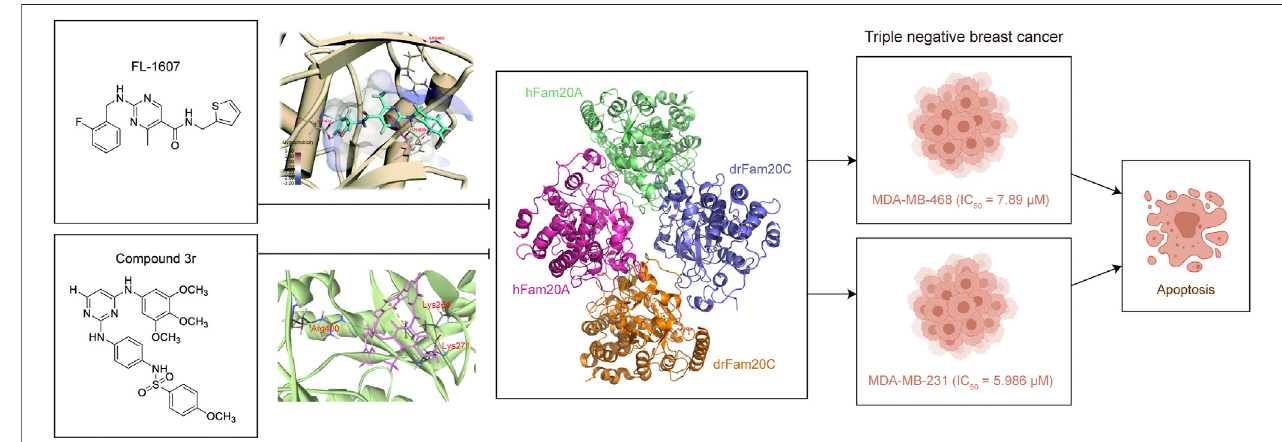
FIGURE 2 | Fam20C inhibitors are designed to treat breast cancer. There are two inhibitors of Fam20C, FL-1607 (Qin et al., 2016) and compound 3r (Zhao et al.,